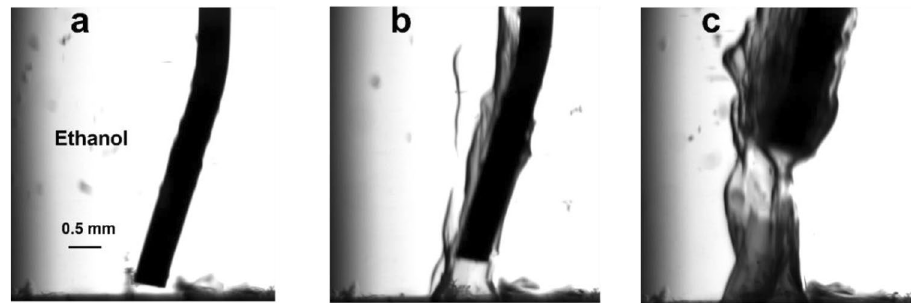
Figure 3. 3D printed objects: case 2. Optical images of the formation of 3D structure from C9 molecules at the water–ethanol interface. ( a ) The nozzle is approaching to the substrate, ( b ) injection of the C9-dithiol in ethanol solution, ( c ) injection of the C9-dithiol in ethanol solution and pulling up the nozzle at the same time.